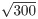
Duplication-Divergence network.The network on the left is a network generated with p = 1 and q = 0.40. It has order 300 and it has 114 nodes with degrees exceeding 300 and so qualify as hubs. The largest few of these hubs have degrees {43, 45, 47, 47, 50}. The network on the right is similarly a network generated with p = 1 and q = 0.60. It is more extended but has only one node of degree equal to one. Its order is 300, and it has 5 nodes of degrees {18, 18, 19, 20, 23} which qualify as hubs. Networks generated with the Modified Duplication-Divergence algorithm have a similar appearance, with the exception that more nodes of degree 1 are seen. The arrangement of nodes and bonds in these networks was created using the prefuse force directed lay-out in Cytoscape 3.4.0 [17].